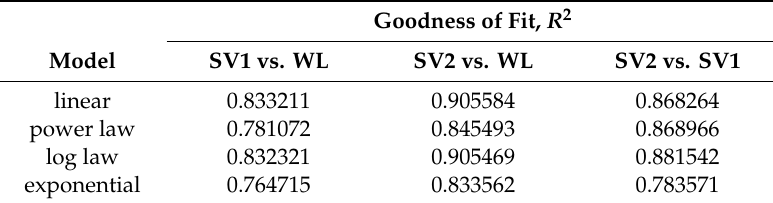
Table 4. Goodness of fit by di ff erent models at Yenfong